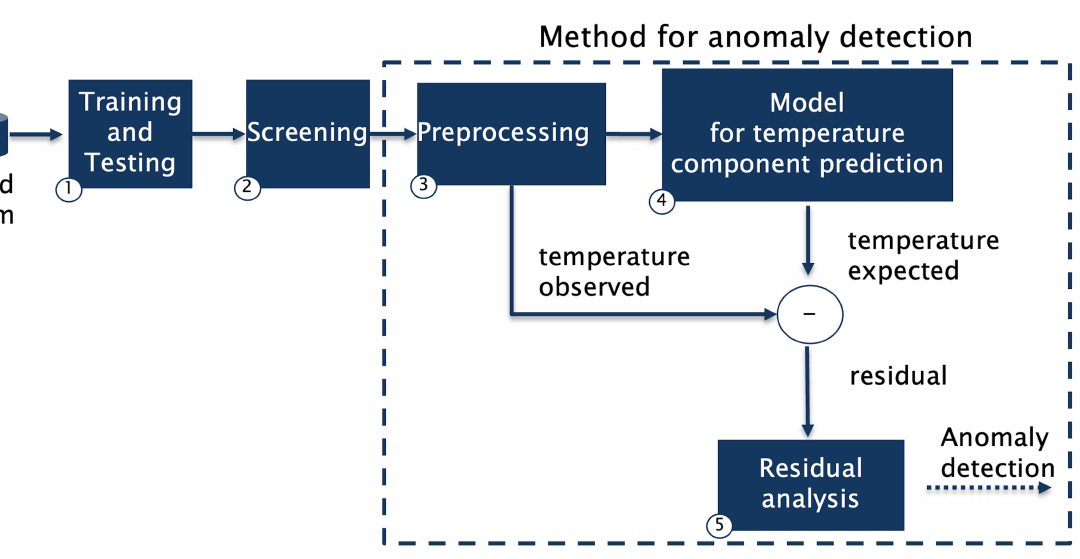
Figure 1. Overview of the controlled experiment. On the bottom left of each block is reported the step number of the